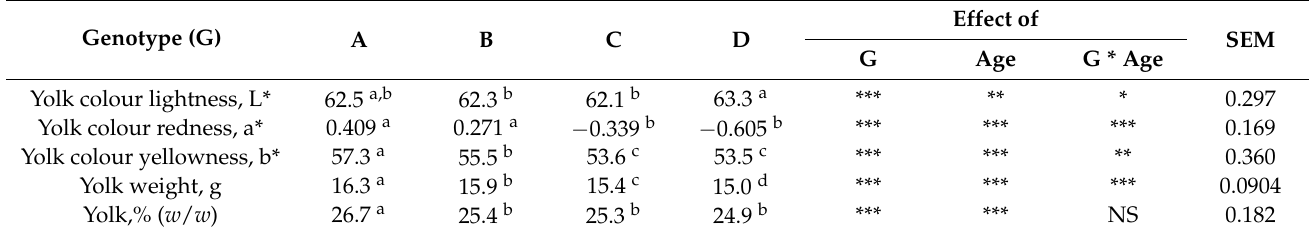
Figure 3. LS-means of egg yolk color parameters and egg mass of four different hen genotypes ( A – D ) as differentiated by hen age (week). Panels showing ( A ) L* (lightness), 0 = black, 100 = white, ( B ) a* (redness), −100 = green, 100 = red, ( C ) b* (yellowness), −100 = blue, 100 = yellow, and ( D ) egg yolk weight, n = 30 for genotype A and 45 for genotypes A, B and C, significant interactions of hen age * genotype ( p < 0.01) for all parameters. Table 3. Effect of hen genotype A, B, C, and D, age, and their interaction on LS-means of egg yolk parameters between the 21st and 54th week of age, n = 180 for genotype A and 270 for genotypes B, C and D. Effect Genotype (G) A B C